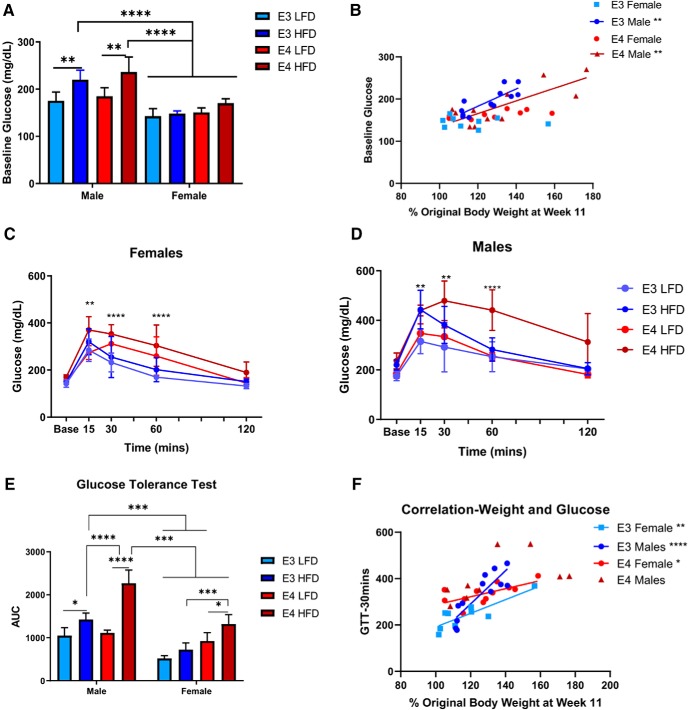
HFD increases baseline glucose and glucose intolerance. Comparison of baseline glucose levels in male and female APOE3 and APOE4 mice, first comparing within sex differences then across sex differences (A). Correlational analyses between weight, glucose levels, and sex. Lines indicate significant correlations (B). GTT in female (C) and male (D) APOE3 and APOE4 mice. Area under the curve (AUC), complete deviation from baseline glucose levels, comparing within sex differences and across sex differences (E). Correlation between genotype, weight gain, sex, and glucose levels at 30 min. Lines indicate significant correlations (F). A, C–E, N = 4–6. Three-way ANOVA Tukey’s multiple comparison test. A, **p < 0.002; ****p < 0.0001; C, **p < 0.003 all groups deviate from baseline at 15 min, ****p < 0.0001 HFD and LFD APOE4 deviates from baseline at 30 and 60 min; D, **p < 0.002 all groups deviate from baseline at 15 min, *p < 0.02 all groups deviate from baseline at 30 min, ***p < 0.0002 HFD APOE4 deviates from baseline at 60 min; E, *p < 0.02, **p < 0.01, ***p < 0.0003, ****p < 0.0001. B, F, Linear regression. B, APOE3 males (N = 12): R
2 = 0.68, p = 0.001. APOE4 males (N = 11): R
2 = 0.63, p = 0.004. F, APOE3 males (N = 12): R
2 = 0.75, p = 0.0002. APOE3 females (N = 9): R
2 = 0.72, p = 0.004. APOE4 females (N = 12): R
2 = 0.42, p = 0.02.